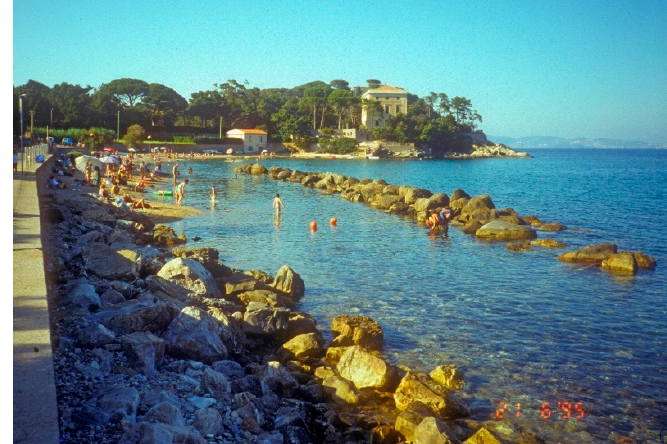
Figure 2. The central part of the beach at Cavo in June 1995.